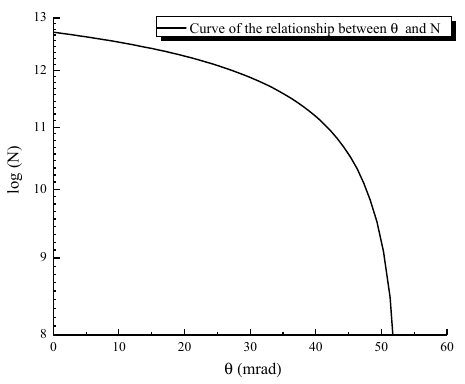
Figure 20. The fatigue properties of the seven-wire strands versus the lateral bending angle.